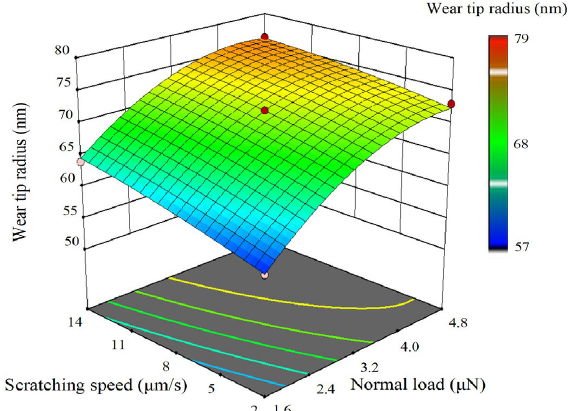
Figure 13. Three-dimensional response surface of wear tip radius .